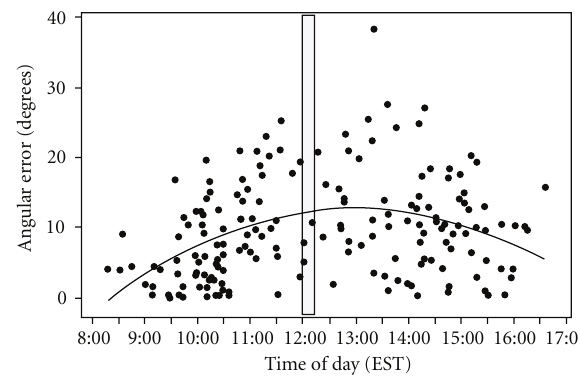
Figure 2: Inaccuracy in the dances of honey bees over the course of a day. The shaded area indicates the time during which the sun is at its highest altitude for the dates that dances were recorded